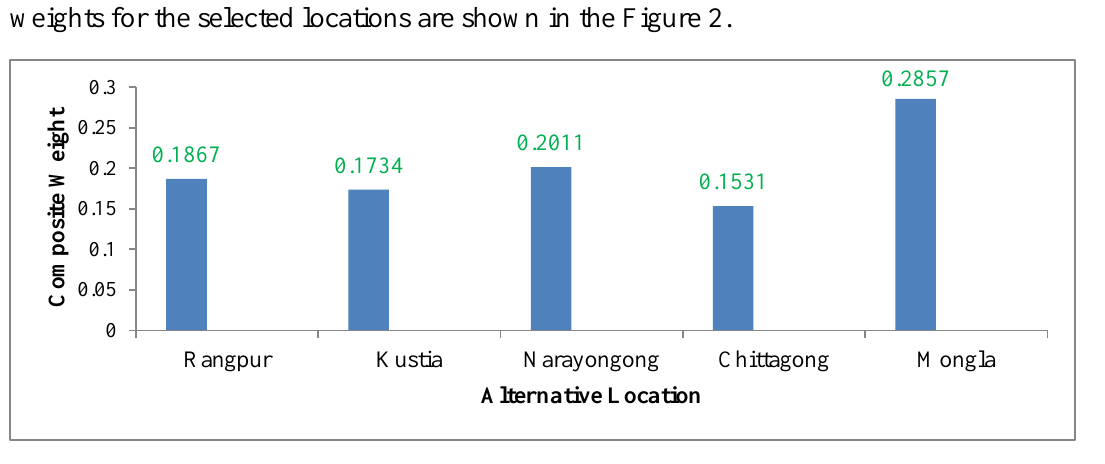
Figure 2. Composite Weight According to